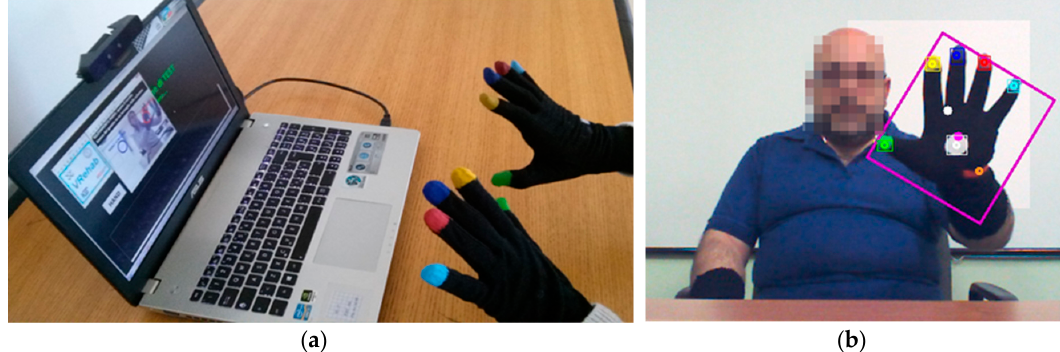
Figure 1. The upper limbs subsystem. ( a ) Example of configuration with notebook for the analysis of fine hand movements and ( b ) tracking algorithm at work: tracking of hand and fingers movements through detection and tracking of 3D-colored blob centroids.